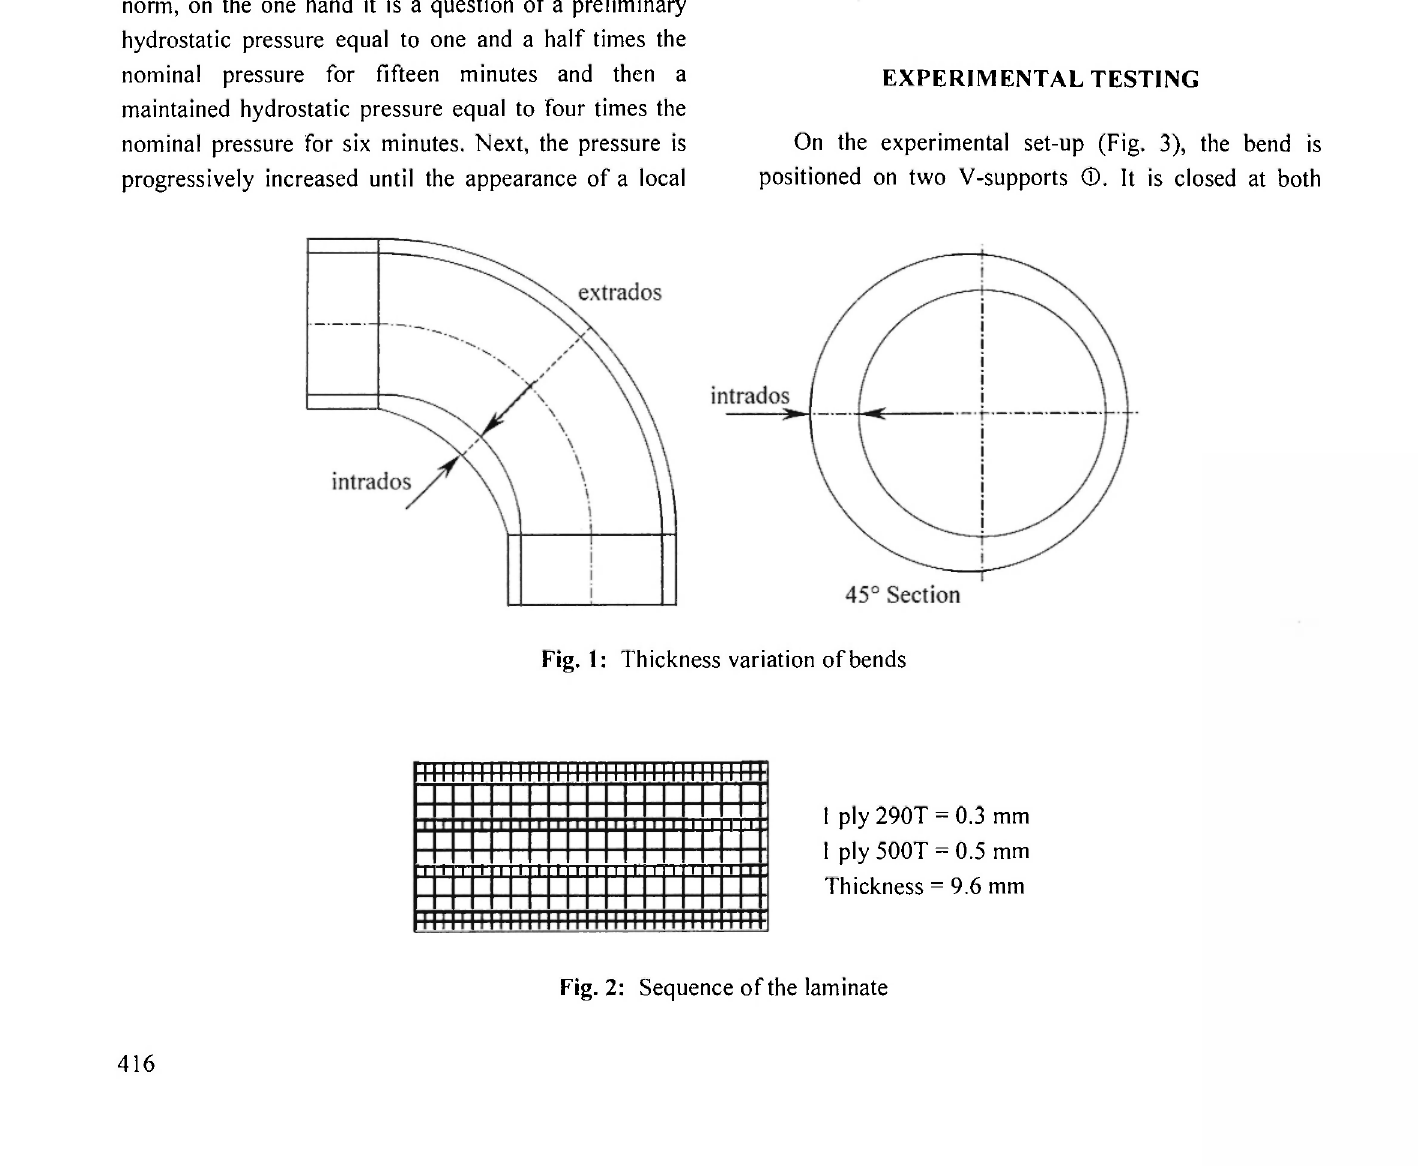
Fig. 2: Sequence of the